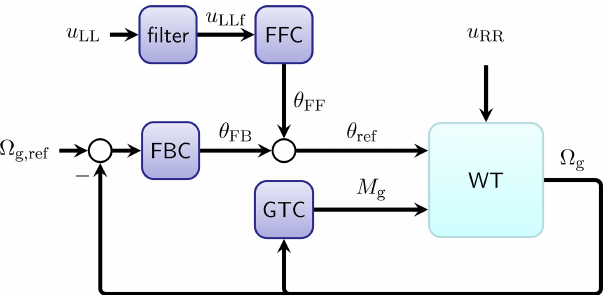
Figure 7. The overall control diagram. FFC: feedforward pitch con- troller; FBC: collective feedback pitch controller; GTC: generator torque controller. Note that the real-time pitch angle ( θ ) signal is also used in the FBC and GTC for controller